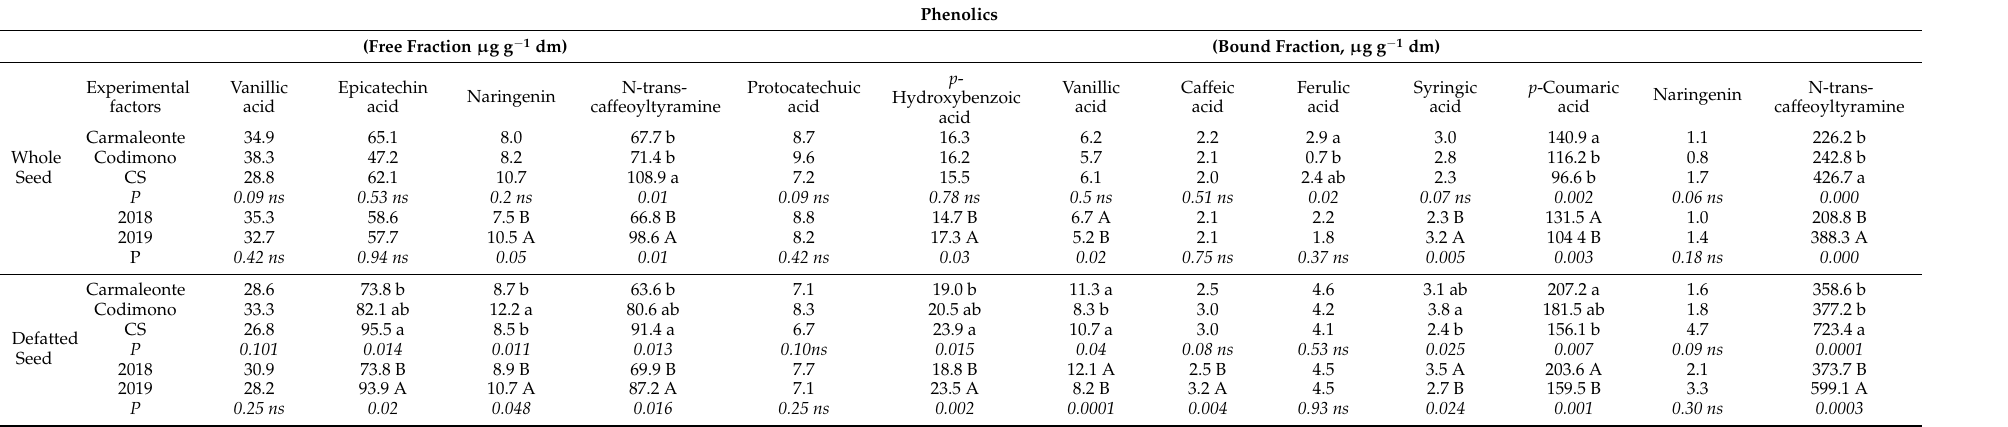
Table 4. Phenolic acids (free and bound) and some simple flavonoid contents determined in whole and defatted seeds of the three Italian hemp cultivars during 2018 and 2019 cropping